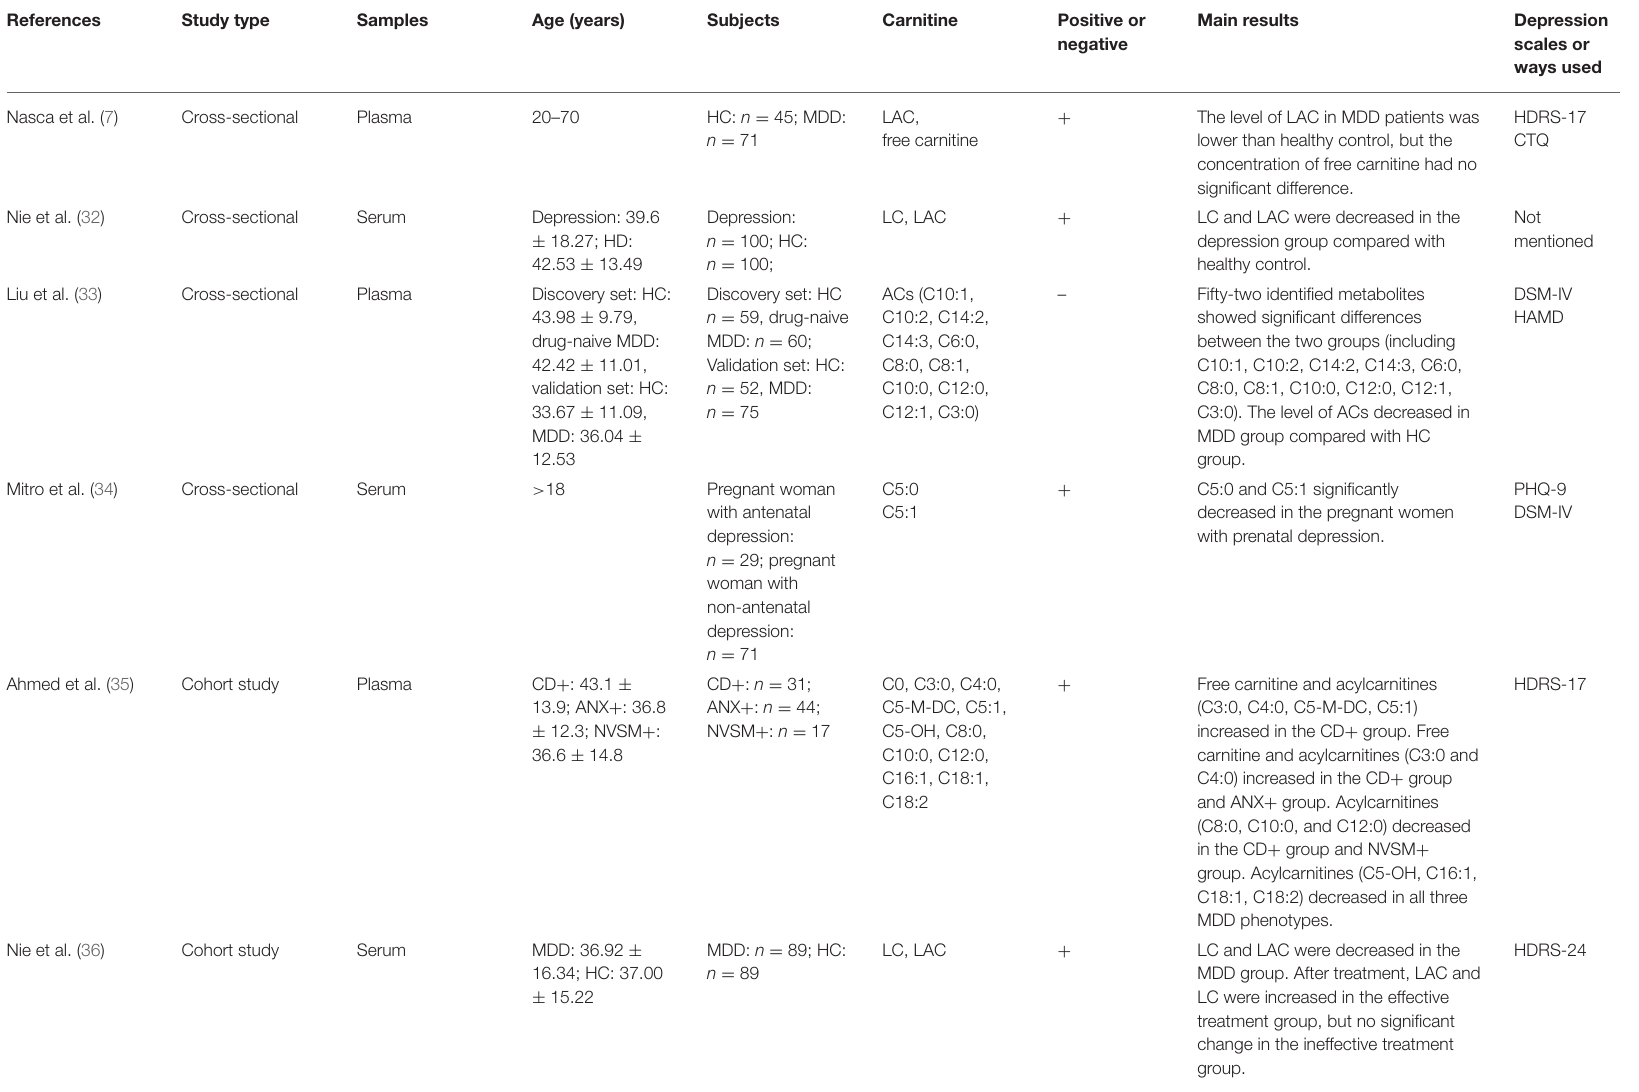
TABLE 2 | Detailed information of studies on carnitine and depression in